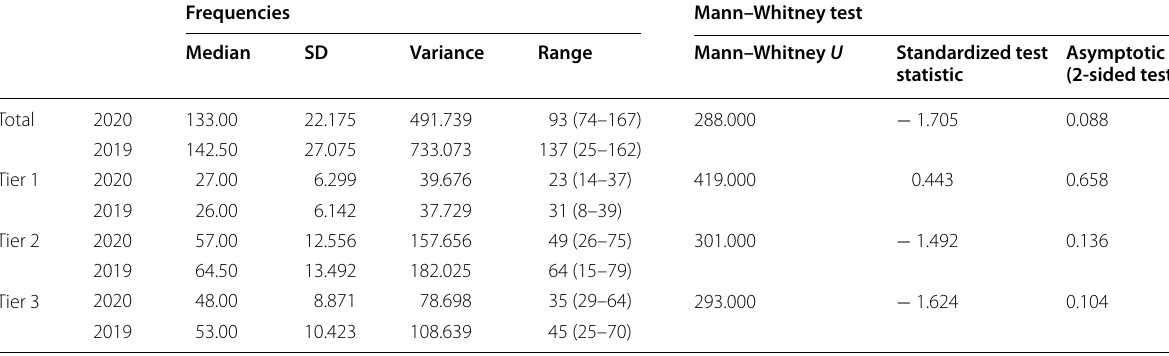
Weekly records of all IR procedures during the COVID-19 pandemic (period specified) and pre-pandemic (2019), classified based on the IR-PAS classification. Evaluation of differences in median weekly caseload across all IR-PAS tiers between the two time periods. No statistically significant differences are noted in the weekly median number of IR procedures performed across all IR-PAS tiers between the two time periods * p <